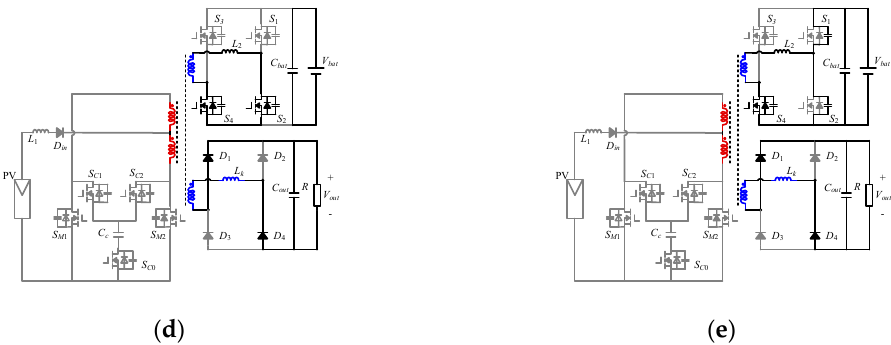
Figure 5. Equivalent circuits of the operation modes without PV source: ( a ) Mode 1 ( t 0 – t 1 ); ( b ) Mode 2 ( t 1 – t 2 ); ( c ) Mode 3 ( t 2 – t 3 ); ( d ) Mode 4 ( t 3 – t 4 ); ( e ) Mode 5 ( t 4 – t 5 ).